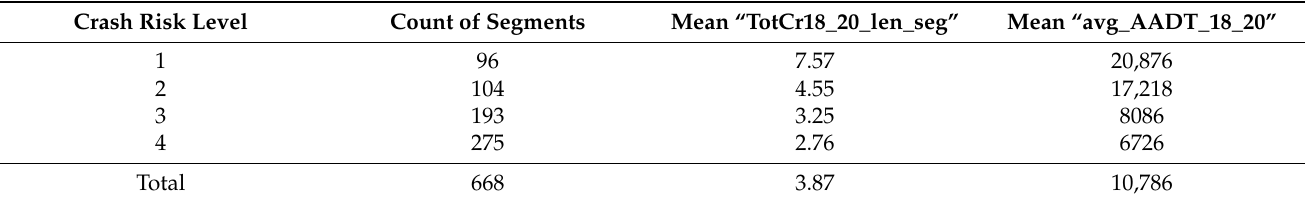
Table 3. Descriptive statistics of the four crash risk levels of the examined motorway segments.